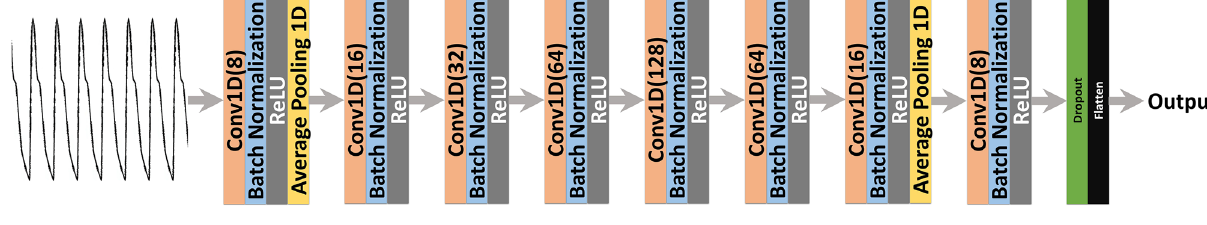
Figure 3. The proposed 1-D CNN network.